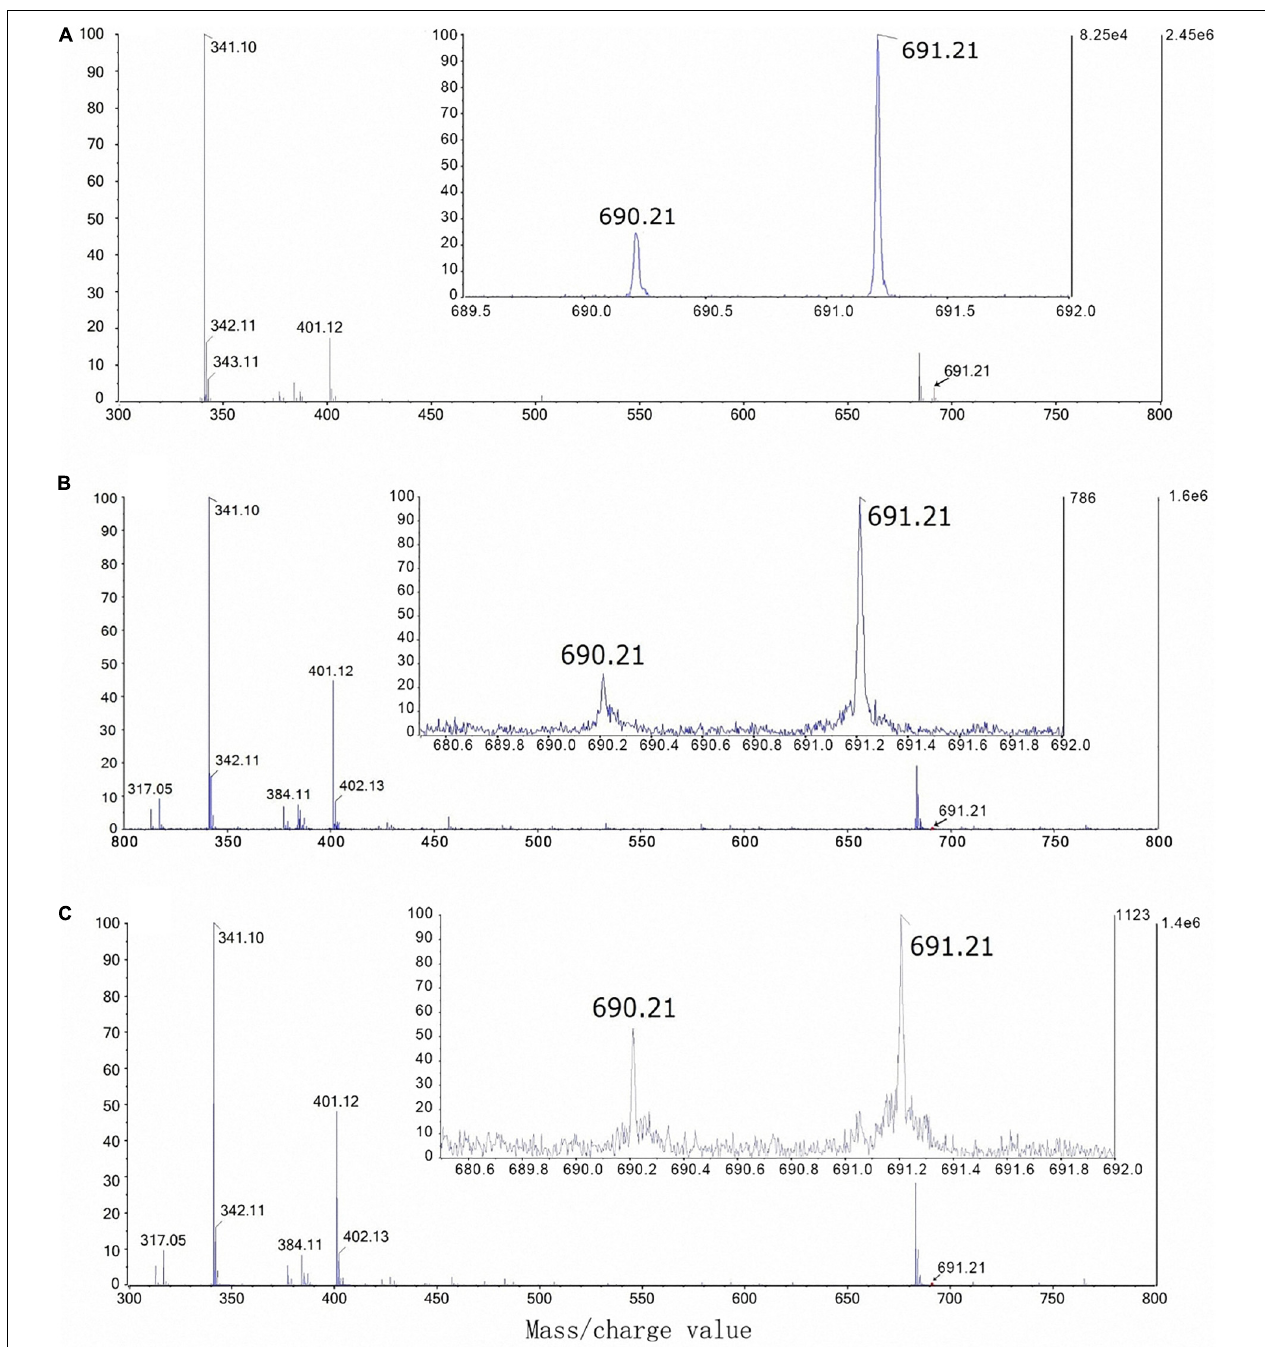
FIGURE 6 | Borate-sucrose complex isolated from the artificial mixture of sucrose (300 mM) and boric acid (0.3 mM) by negative mode ESI-Q-TOF-MS (A) ; from the phloem sap of foliar-water plants (T1) by negative mode UPLC-ESI-Q-TRAP-MS (B) ; and from the phloem sap of foliar- 10 B plants (T2) by negative mode UPLC-ESI-Q-TRAP-MS (C)